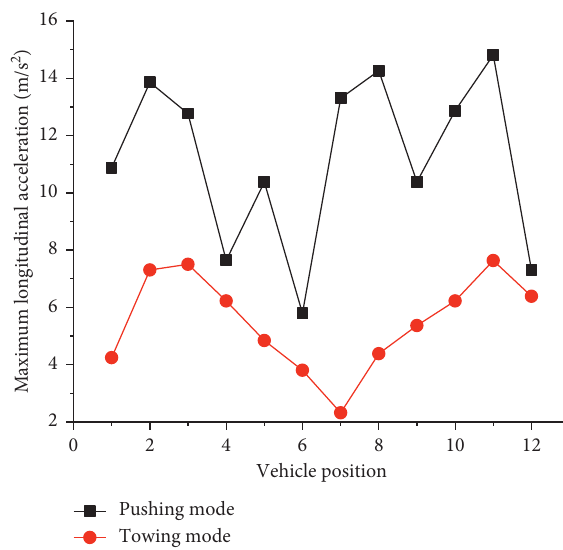
Figure 8: Maximum longitudinal acceleration when AW0 rescues